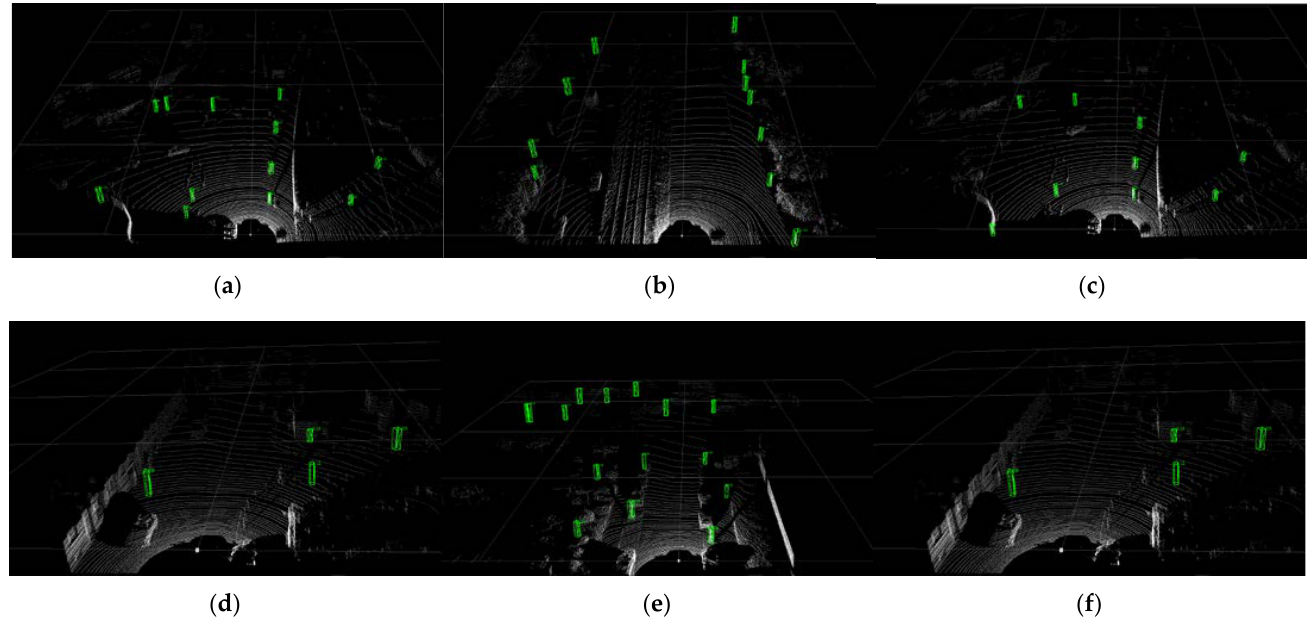
Figure 11. Test results of PV-RCNN. ( a ) Three-dimensional view ( b ) Three-dimensional view ( c ) Three-dimensional view ( d ) Three-dimensional view ( e ) Three-dimensional view ( f ) Three-dimensional view.